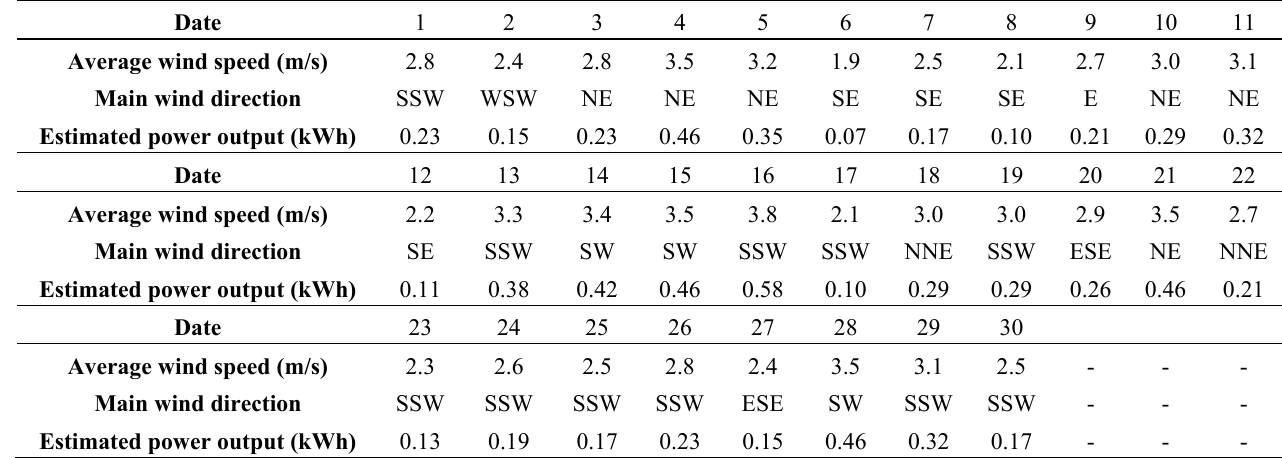
Table A6. Estimated power output per day in